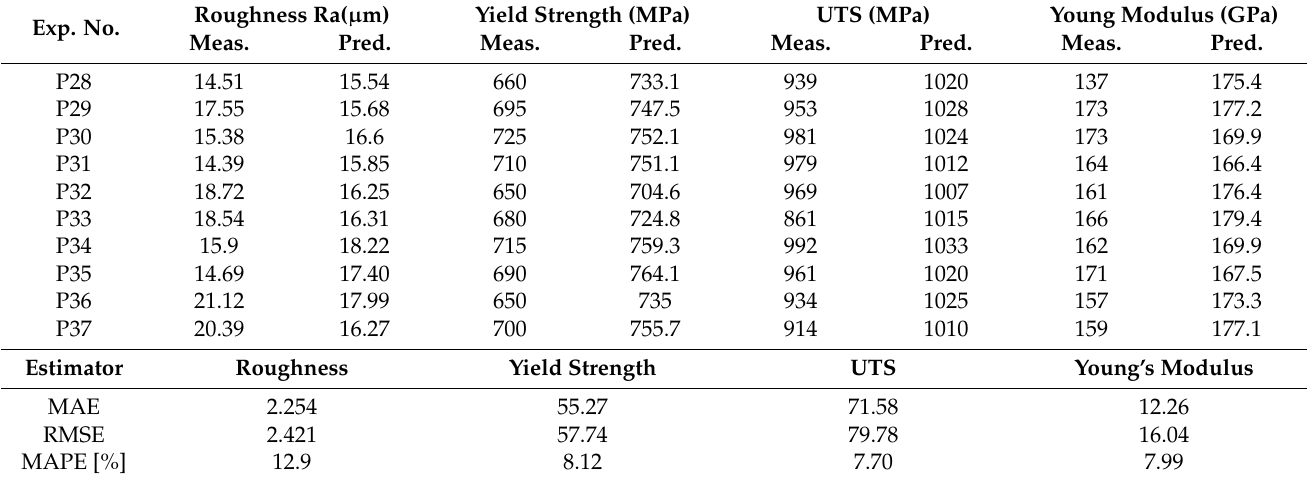
Table 5. Results for the performance of the regression models on the validation